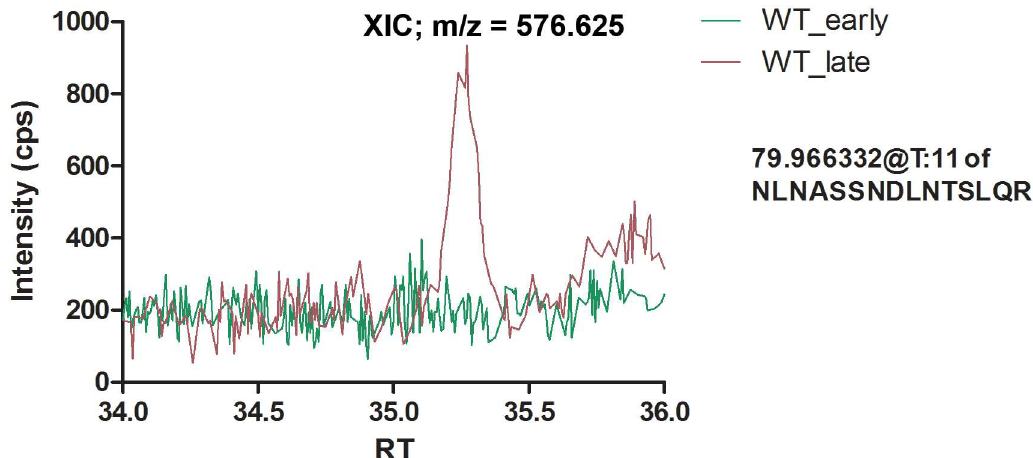
Fig 1. Identification of T27 phosphorylation in PAO1 FliC. Peak profile of T27 corresponding to the presence of phosphorylation in the late log phase of PAO1 WT. WT_early and WT_late denote FliC extracted from early (6 h) and late log (13 h) phase of PAO1 WT. Mass difference of 80 Da indicates phosphorylation at T27 site of FliC extracted from late log phase of PAO1 WT. Cps and RT represent counts per second and retention time respectively. Extracted ion chromatogram (XIC) denotingthe mass-to-charge (m/z) ratio of the peak of interest is 576.25.